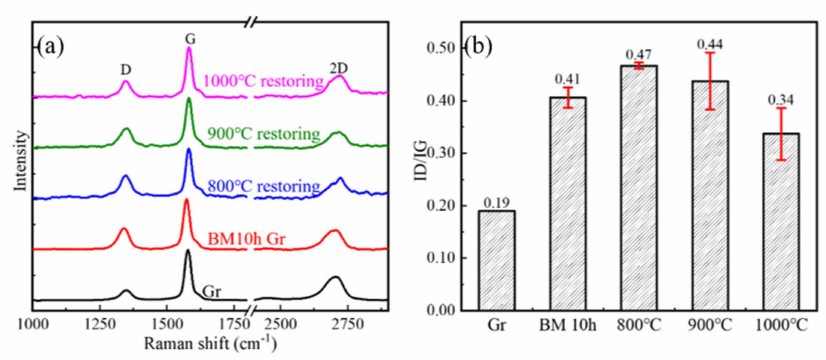
Figure 7. The Raman spectrum and I D / I G statistics of BM10h GNPs repaired at different temperatures in CVD process. ( a ) Raman spectrum, ( b ) I D / I G statistics.